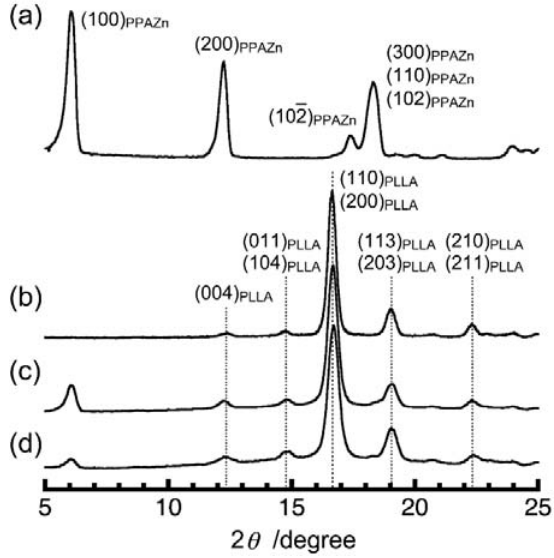
Figure 6. Powder X-ray diffraction (XRD) patterns of ( a ) PPAZn microcrystalline powder, ( b ) neat PLLA which was melt crystallized at 140 °C for 2 h, ( c ) PPAZn/PLLA-0T, and ( d ) PPAZn/PLLA-8TS. To evaluate the crystal orientation of PLLA, and its correlation with the magnetic alignment of